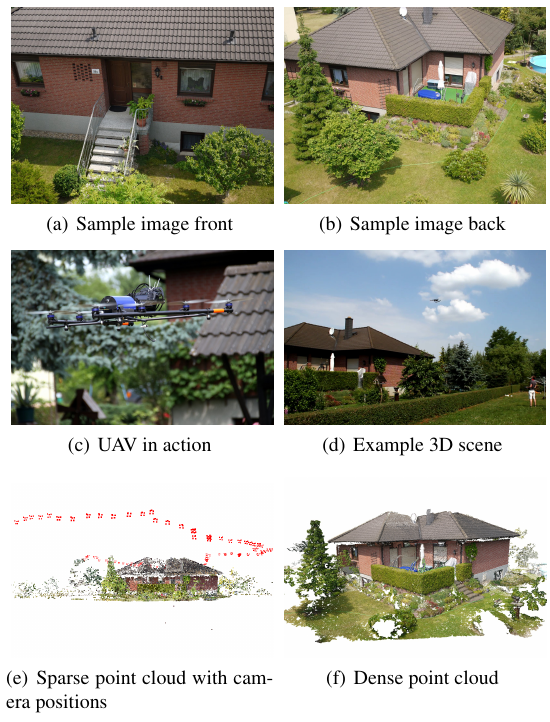
Figure 8: 3D Reconstruction by usage of a